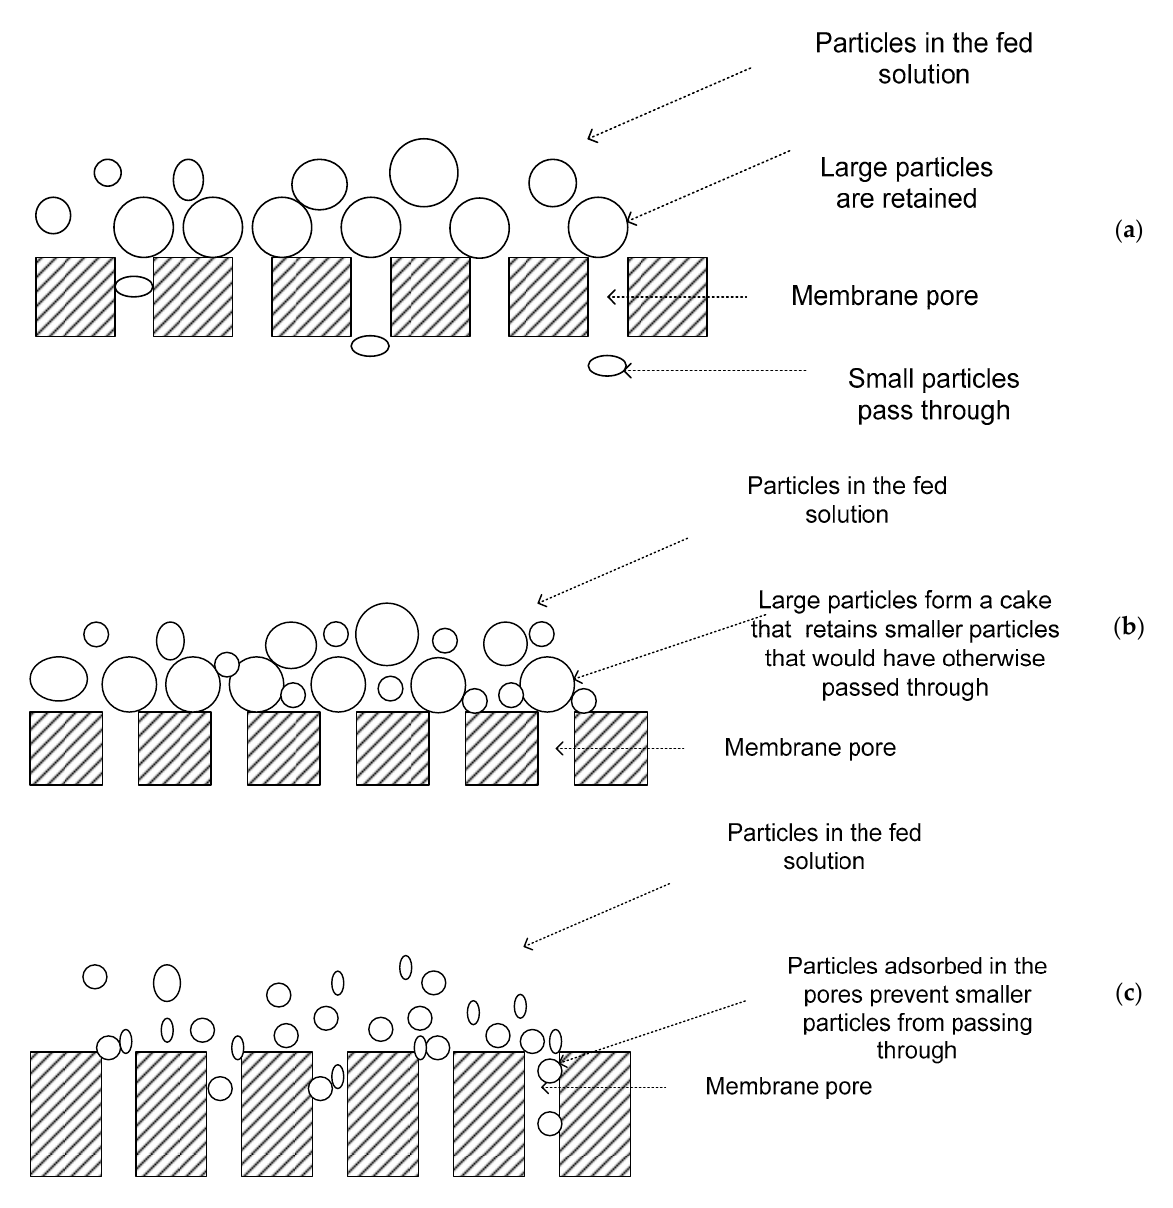
Figure 1. ( a – c ) Mechanisms of micro fi ltration and ultra fi ltration.